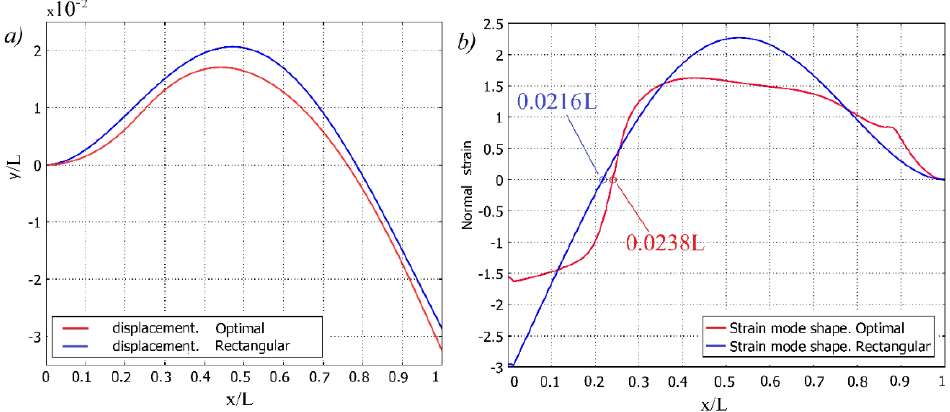
Figure 3. Second transverse vibration mode of a cantilever: ( a ) displacement; ( b ) normal strain.